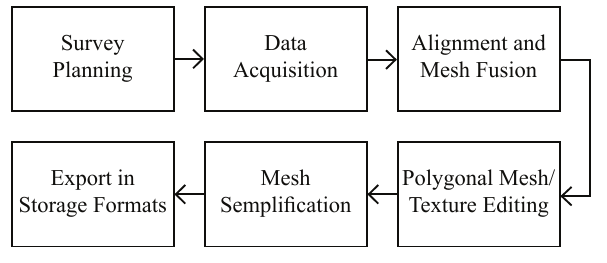
Figure 4. Acquisition and post-processing work- fl